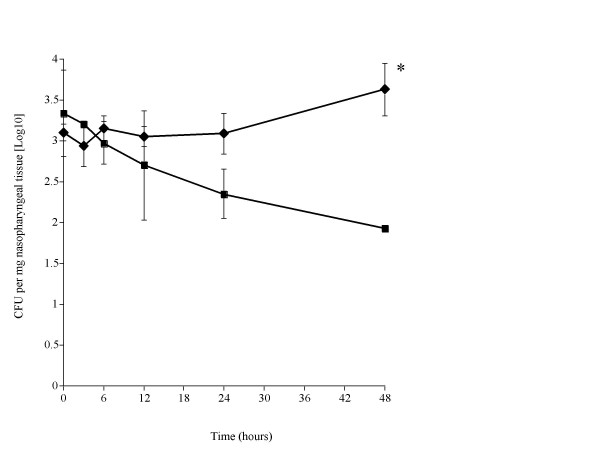
Time course of the change in numbers of S. pneumoniae in the nasopharynx (figure 1), trachea (figure 2), lungs (figure 3) and blood (figure 4) of SP-D-/- (◆) and SP-D+/+ (■) mice infected intranasally with 106 CFU (n = 10 mice at each time point, error bars indicate SEM). * denotes P < 0.01, ** denotes P < 0.05 for SP-D-/- when compared to wildtype at equivalent time point.